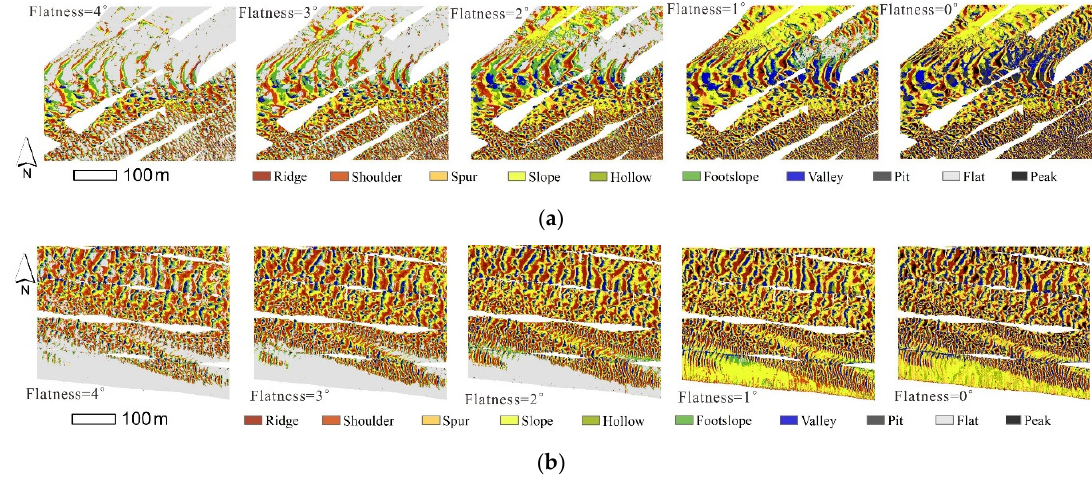
Figure 7. Geomorphons-based distribution of geomorphic elements with different flatness degrees